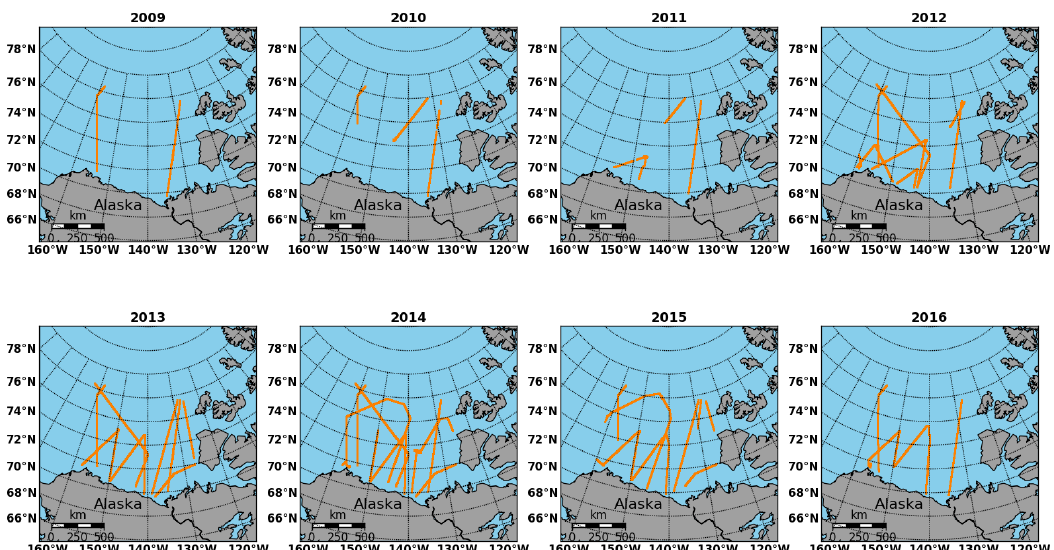
Figure 3. Operation IceBridge flight track sections utilized for